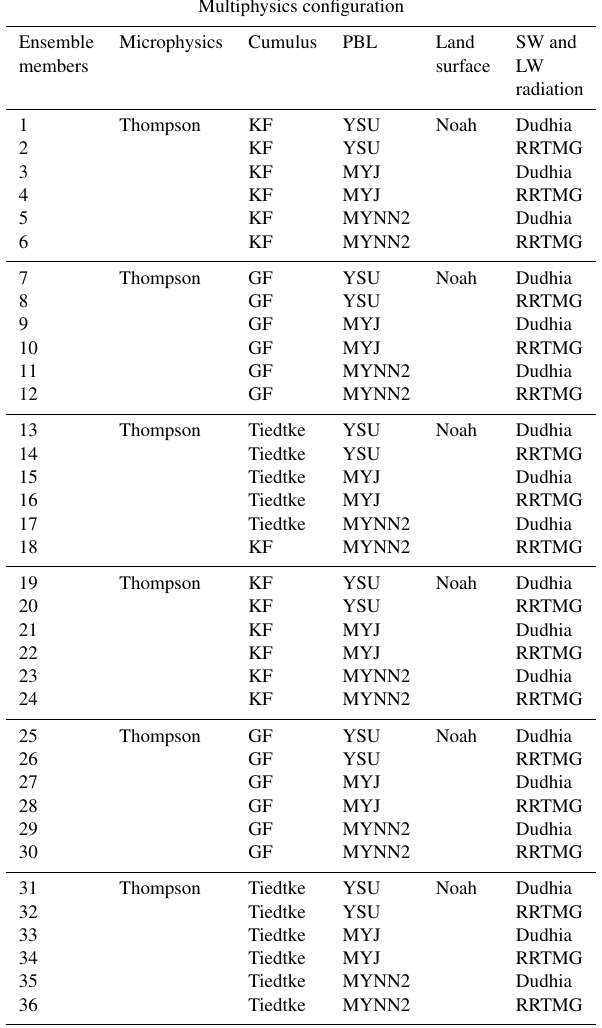
Table 1. Multi-physics parameterizations used on the WRF ensem- ble system presented in this study. Here PBL, SW and LW stand for planetary boundary layer, shortwave and longwave,